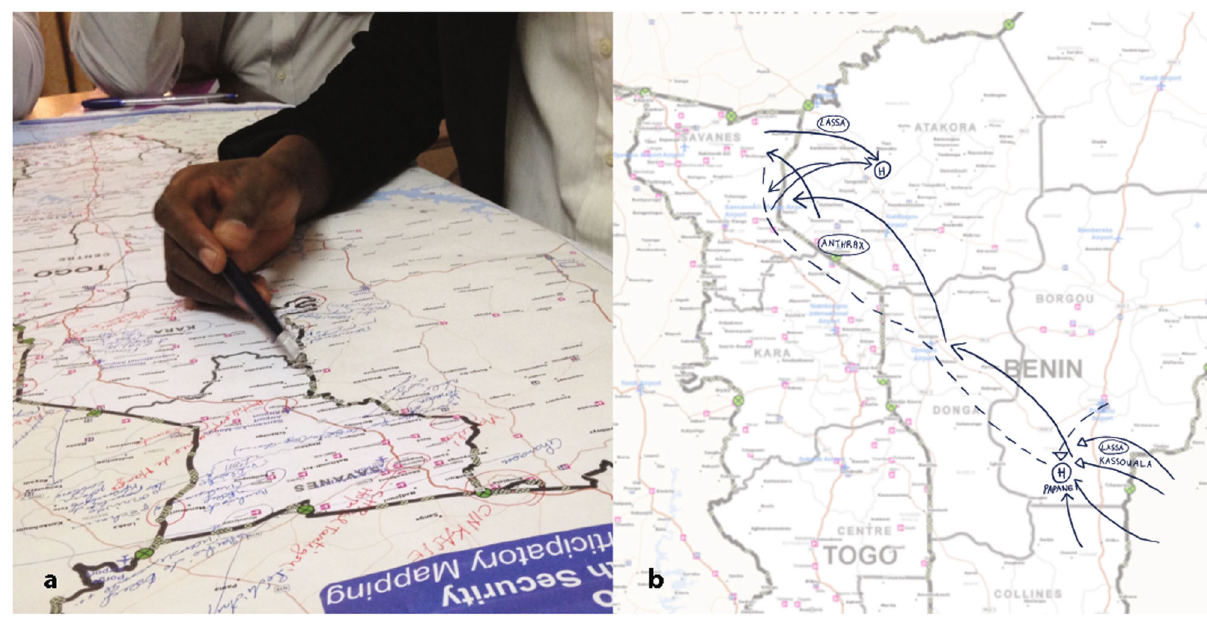
Fig. 2 Annotated maps from Population Connectivity Across Borders (PopCAB) participatory mapping completed during focus group discussions at a binational meeting between Togo and Benin. a Photo of participants of the Togo focus group discussion annotating a national-level map; b Digital enhancement of annotations on the Benin national map.